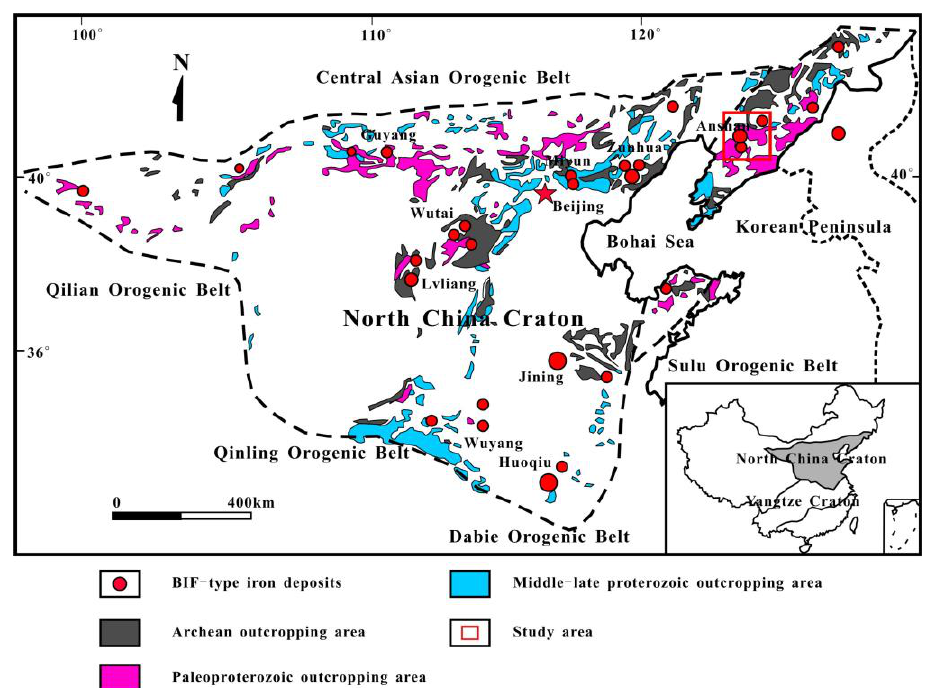
Figure 1. The distribution sketch of the Precambrian geology banded iron formation (BIF)-type iron deposits (modified from Zhang et al., 2012 [13]).